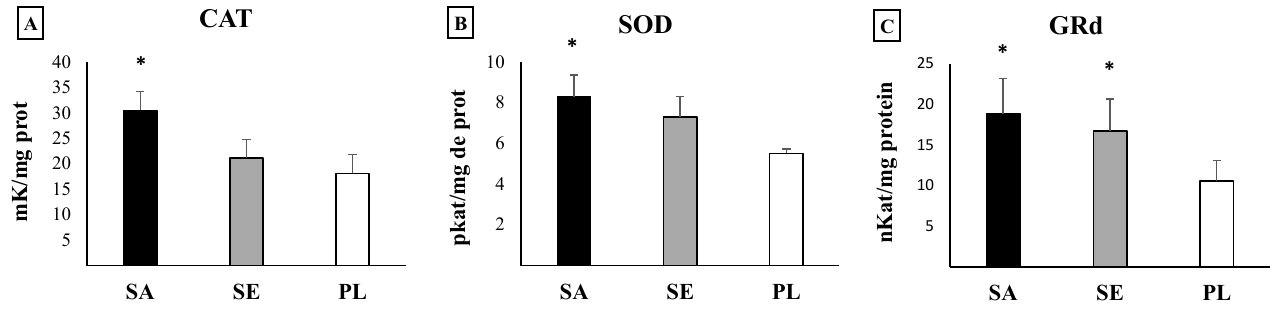
Figure 3. Activities of antioxidant enzymes in the digestive tract of H. tubulosa : ( A ) catalase (CAT); ( B ) superoxide dismutase (SOD); ( C ) glutathione reductase (GRd). Significant differences ( p -value < 0.05) are shown: * indicates differences respect to PL. SA, Sant Antoni de Portmany; SE, Santa Eulària des Riu; PL, Pou des Lleó.